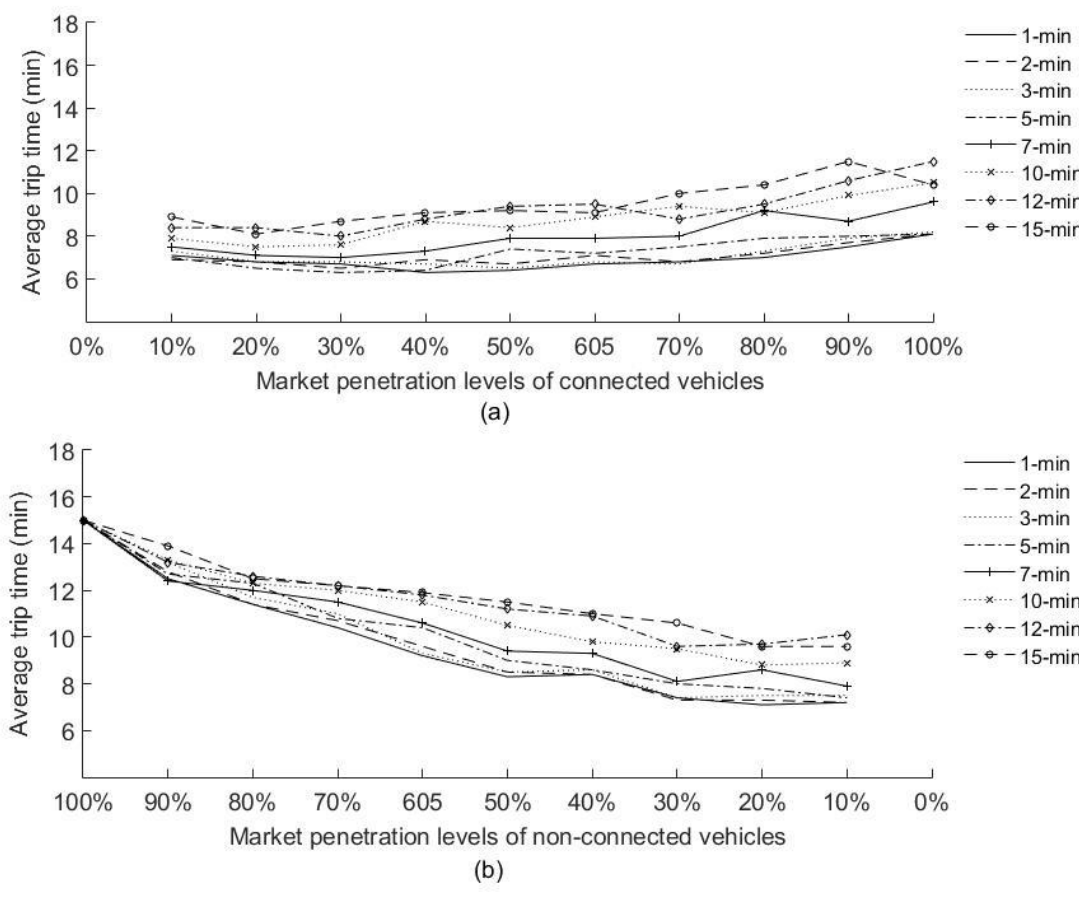
Figure 6. Comparison of the ATTs for connected vehicles and non-connected vehicles: (a) Connected vehicles; (b) Non-connected vehicles Second, in term of AVS, the effect of market penetration level and information updating interval is shown in Figure 7. For all the updating intervals, AVS decreases slightly from around 31 to 28 km/h with an increase of market penetration level. There is no significant difference among them. AVSs of connected vehicles and non-connected vehicles are compared separately in Figure 8. AVSs of connected vehicles decline by around 8 k/h with increased levels of connected vehicles. Simultaneously, AVSs of non-connected vehicles could